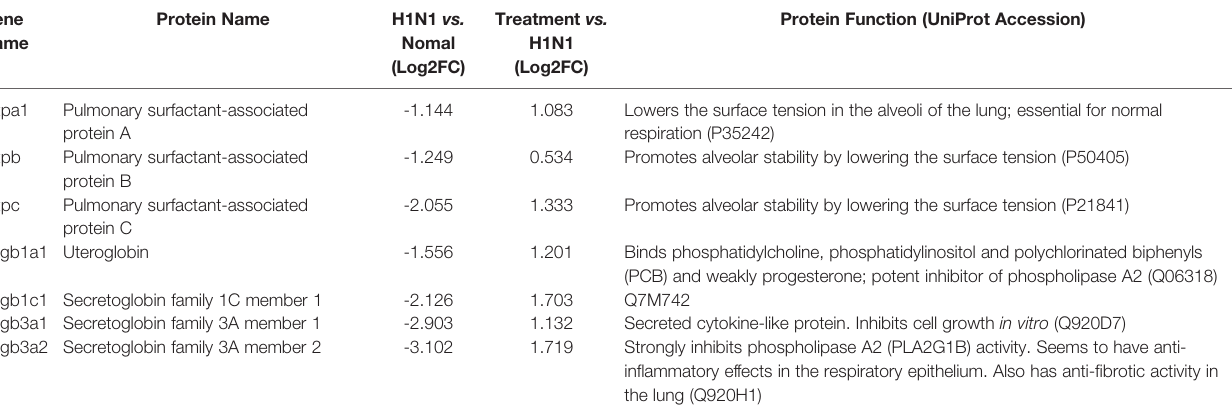
TABLE 1 | Differentially expressed epithelial genes.